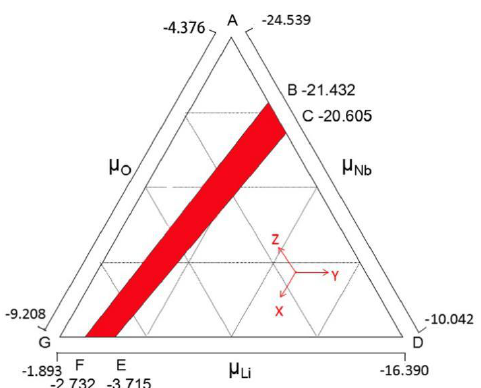
Figure 1. Stability range of chemical potentials of the elements in LiNbO 3 . The chemical potential in the red region satisfy all the limit conditions, and the line BF, CE represent the reference state Li 2 O and Nb 2 O 5 , respectively.